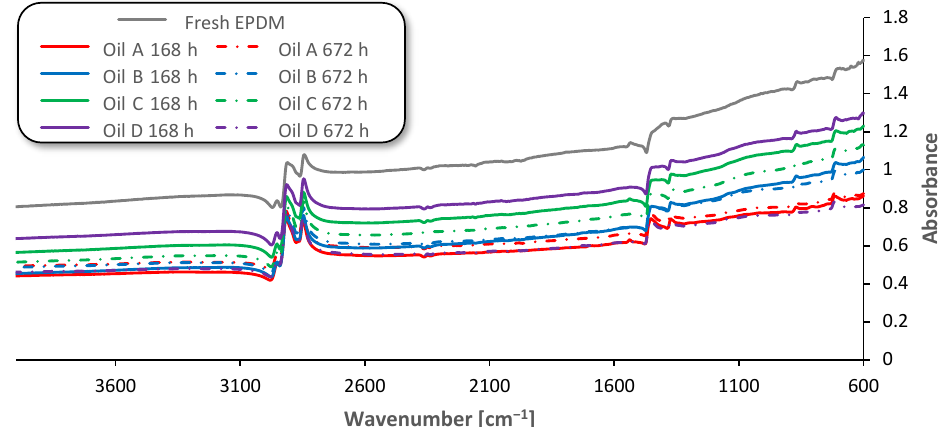
Figure 9. ATR-FTIR absorbance spectra (Beer’s Law) of the EPDM samples.